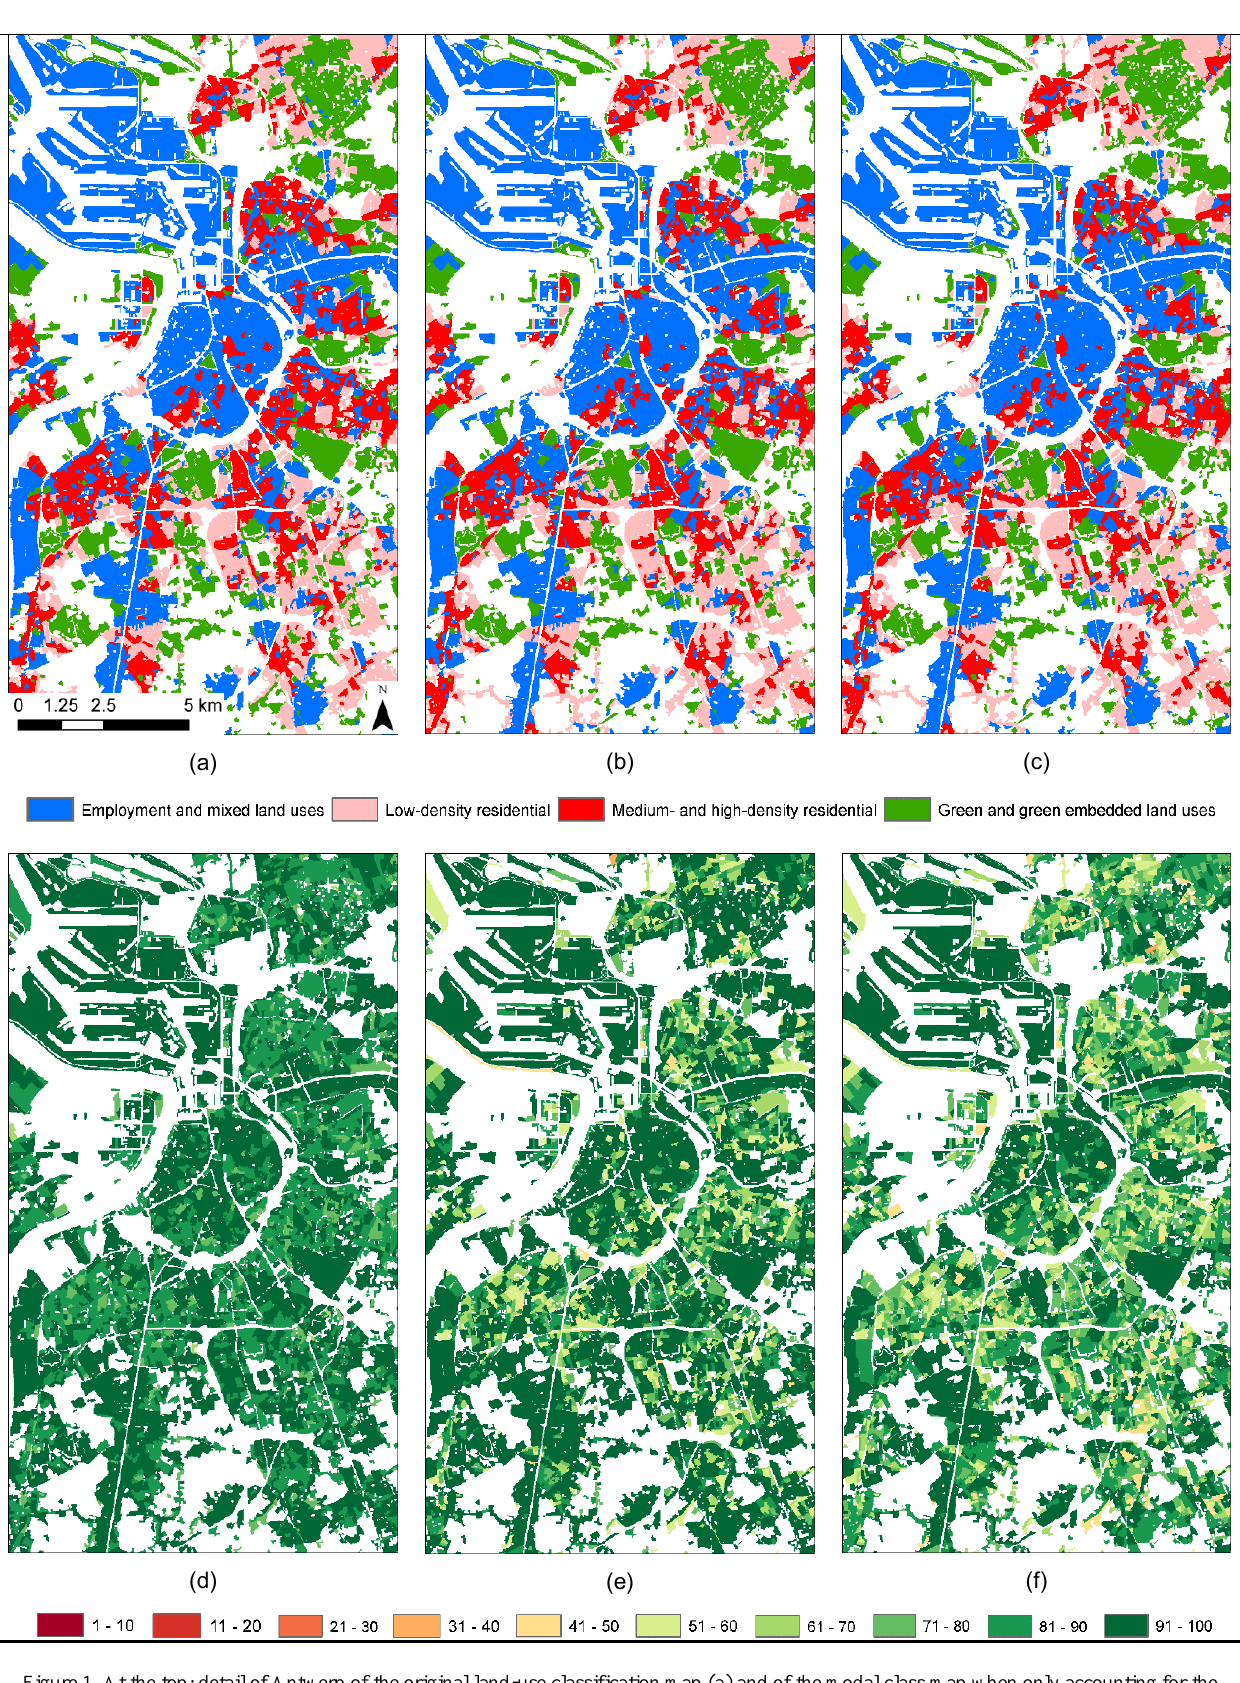
Figure 1. At the top: detail of Antwerp of the original land-use classification map (a) and of the modal class map when only accounting for the impervious surface errors (b) and when combining both uncertainty sources (c). At the bottom: the modal frequency maps of the classification errors only approach (d), of the impervious surface errors only approach (e) and of their combined impact